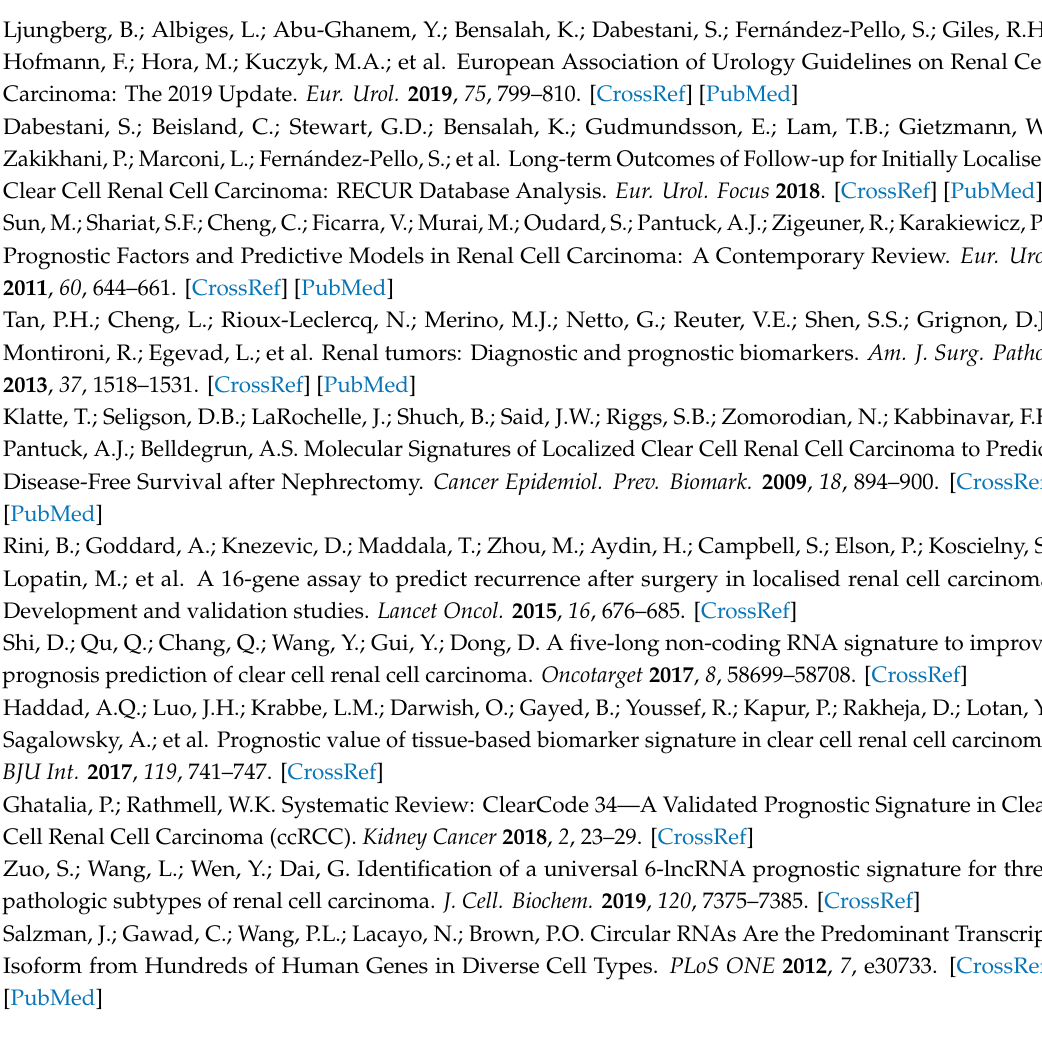
and linRNAs, Table S8: Univariate Cox regressions of clinicopathological factors, Table S9: Bootstrapping p -values of Cox regression